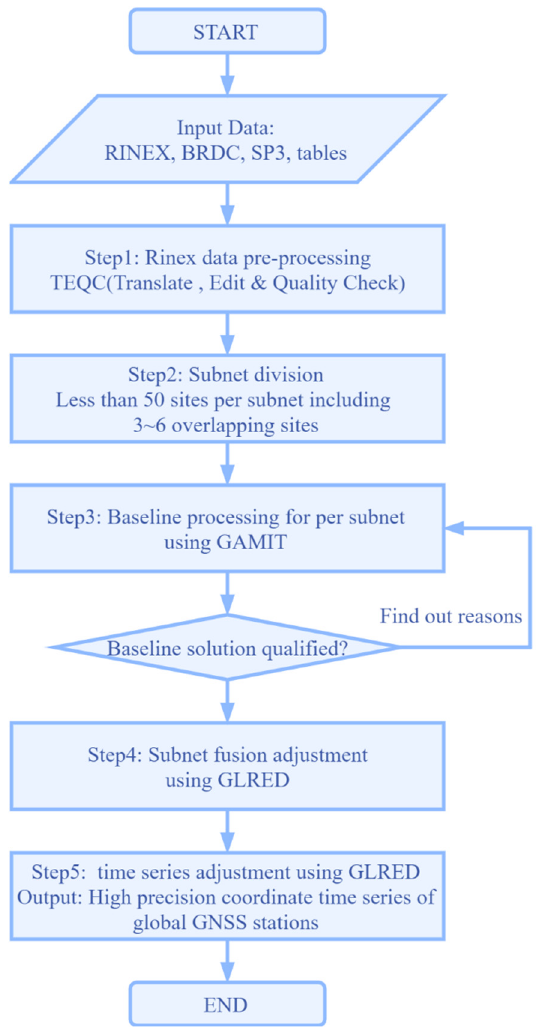
Figure 3. High-precision GNSS data processing flow based on the GAMIT/GLOBK software.